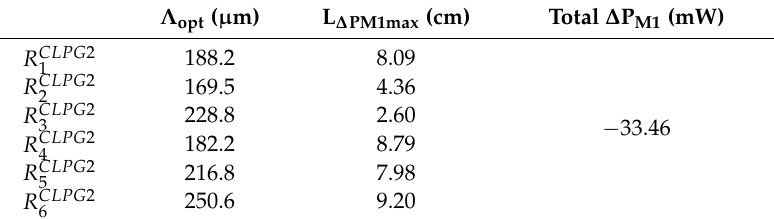
Table 6. Parameters of grating cascade CLPG 2 , grating length L ∆ PM 1 max globally maximizing